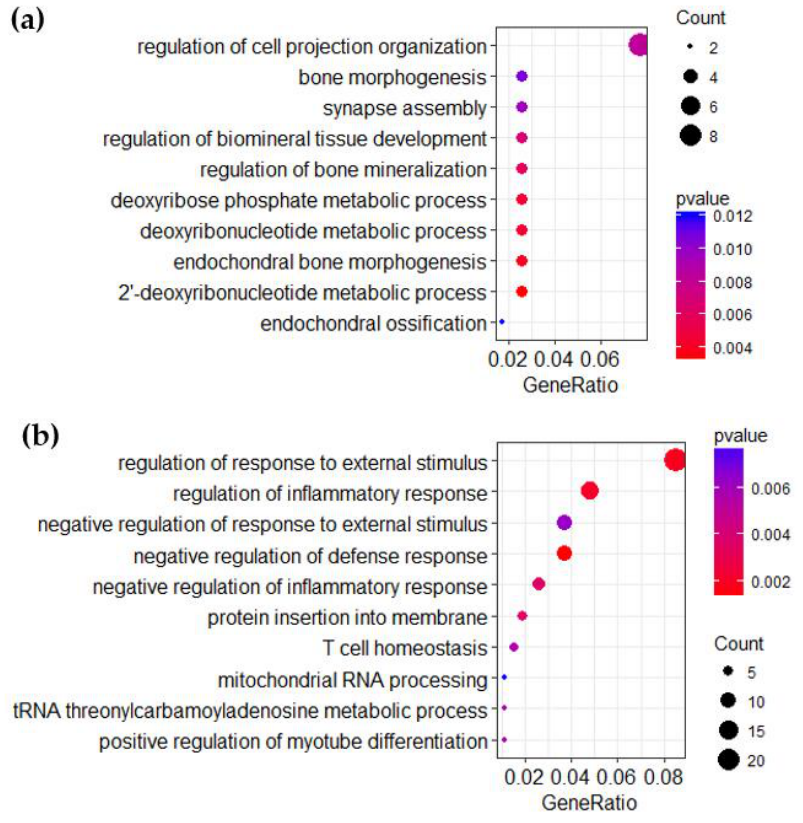
Figure 3. Over-representation analysis of Gene Ontology biological process categories. In the figure, the color of the dots indicates the p -value, the size of the dots indicates gene count, and the GeneRatio indicate the “number of genes in common between gene list and GO-category/number of genes in gene list.” ( a ) Over-representation analysis for “all women,” using the 139 significantly differentially expressed genes between high and low coffee consumers. ( b ) Over-representation analysis for “low tea, nonsmokers,” using the 297 significantly differentially expressed genes between high and low coffee consumers.